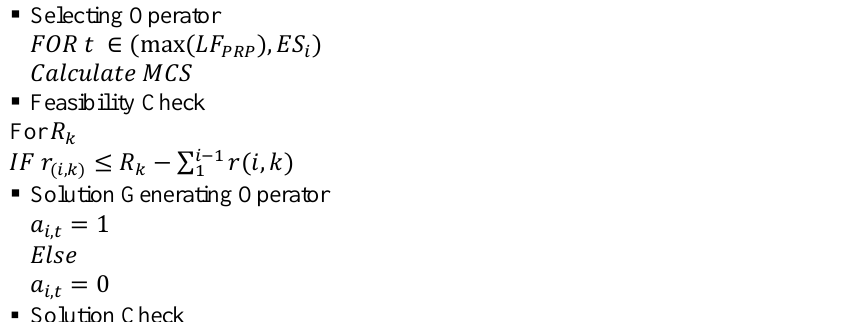
Pseudo-code for Employing Greedy Algorithm in PCP Operator  Selecting